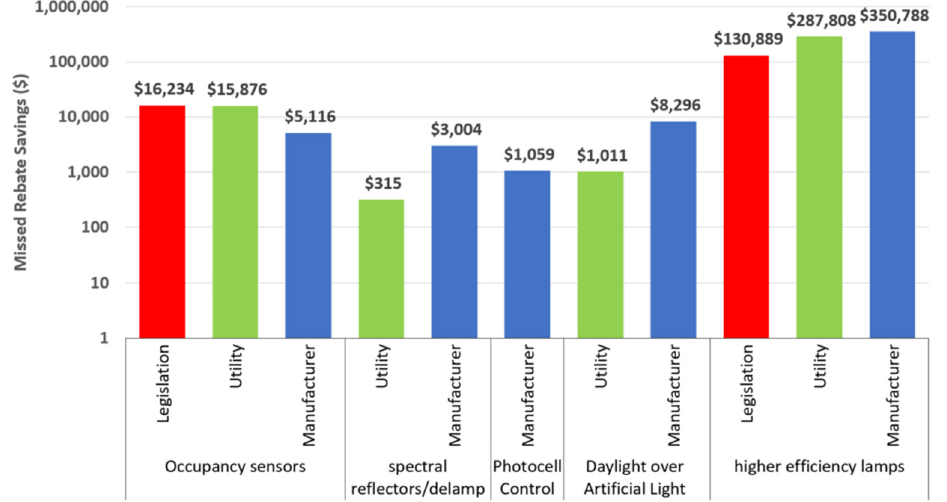
Figure 4. Total predicted rebates missed for each AR and scenario for missing rebates.